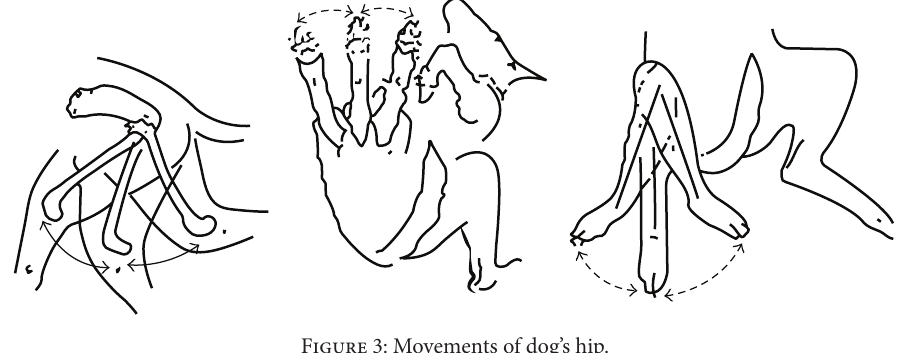
Figure 3: Movements of dog’s hip.